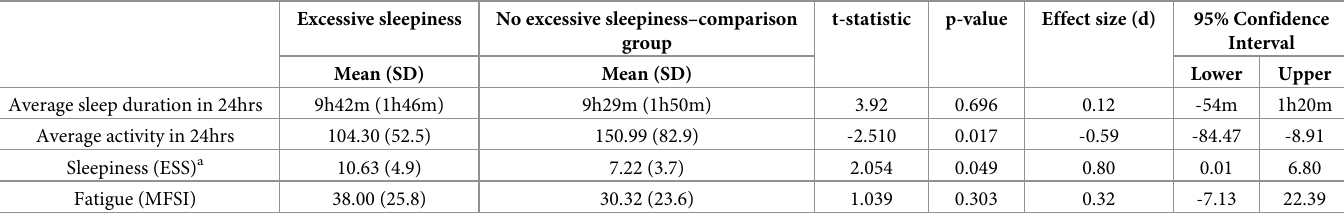
Table 2. Sleep-related differences between the excessive sleepiness and comparison groups.